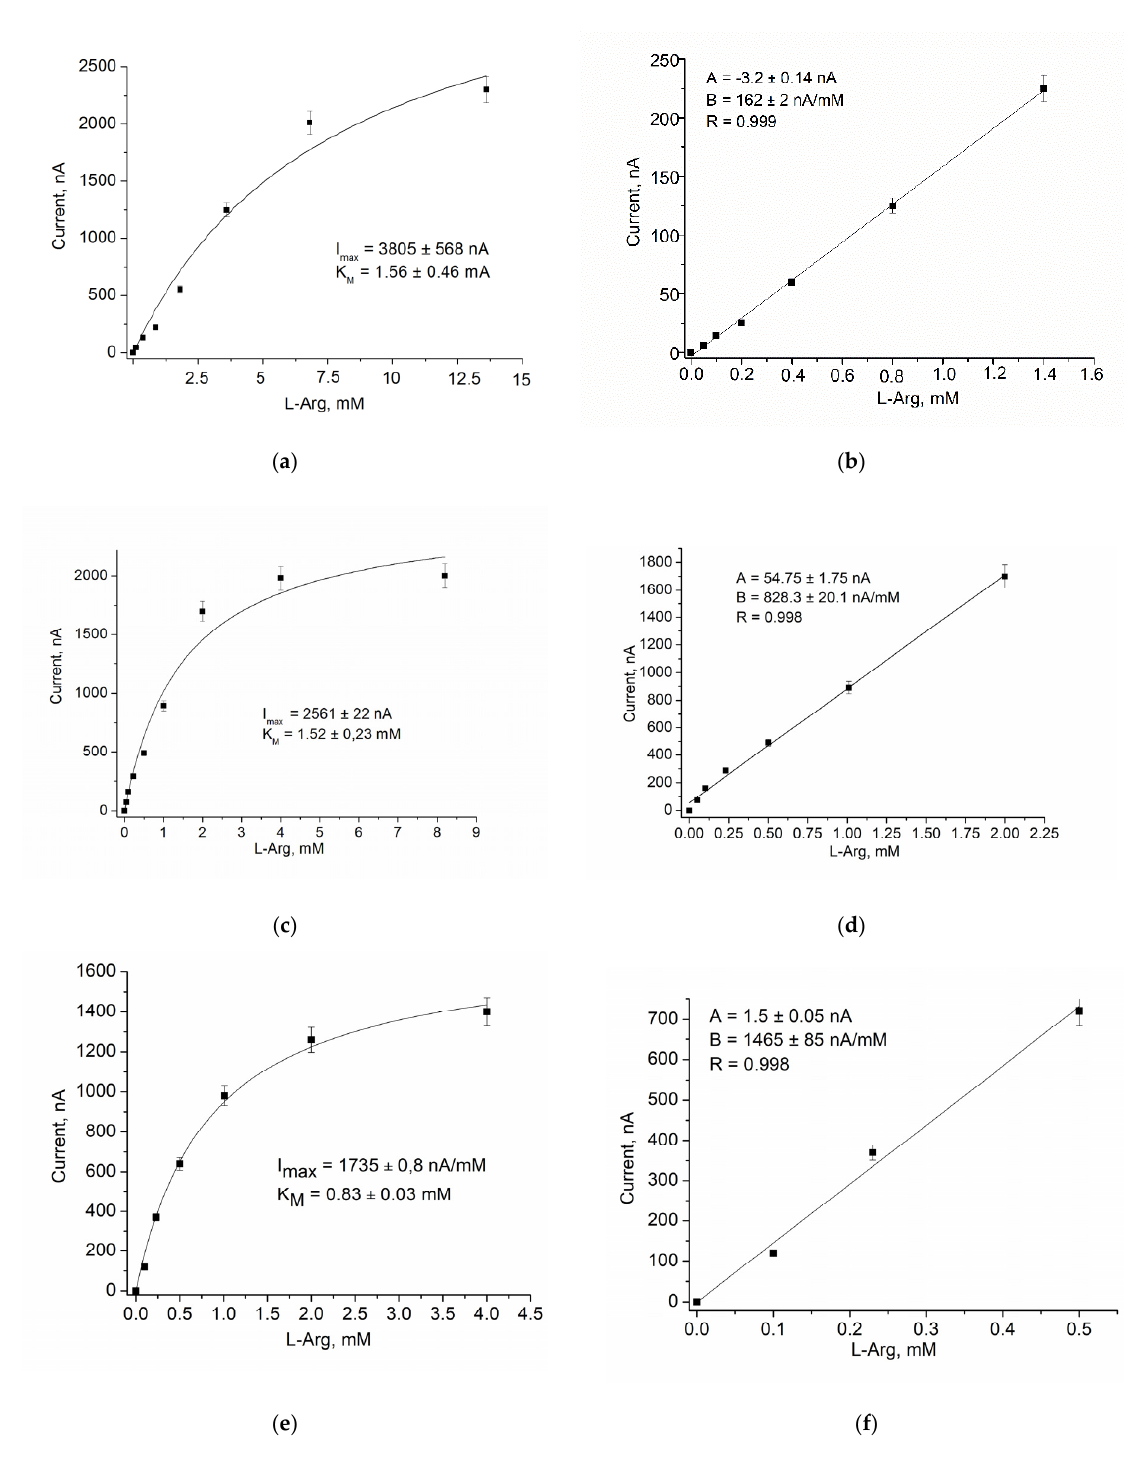
Figure 7. Amperometric characteristics of the ArgO/PO/GE ( a , b ), the ArgO/nCuCe/GE ( c , d ), and the ArgO/nCuCe/pAu/GE ( e , f ): ( a , c , e ) dependence of amperometric signal on concentration of L-Arg; ( b , d , f ) calibration graphs for L-Arg determination. Conditions: working potential –150 mV vs. Ag/AgCl/3 M KCl in 50 mM PB, pH 7.5.